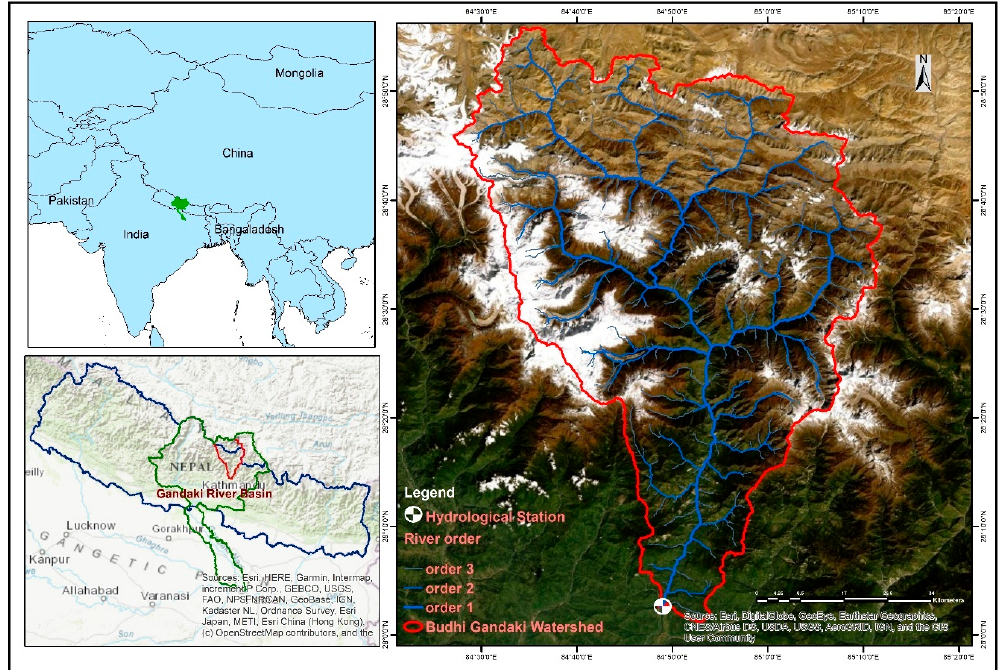
Figure 1. The topographic and administrative status of the study area.